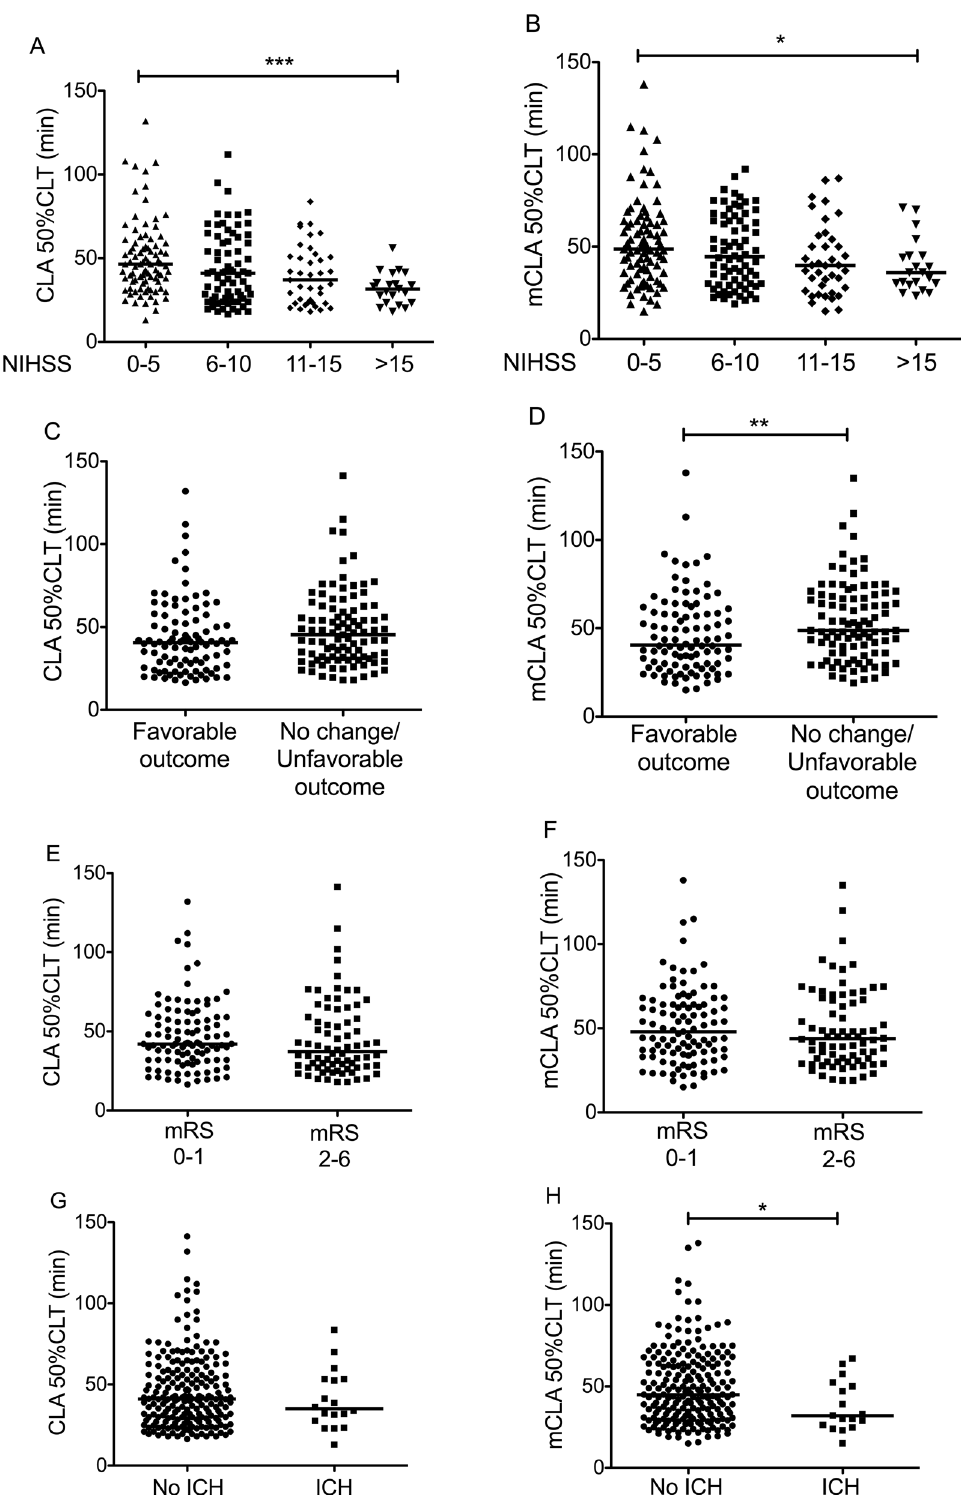
Figure 2. Association between 50% clot lysis time (50%CLT) parameter of the clot lysis assay (CLA) or modified clot lysis assay (mCLA) and the severity and outcomes of stroke. Association between the 50%CLT parameter of CLA and stroke severity ( A ), short term outcome of stroke ( C ), long-term outcome of stroke ( E ), and therapy-associated intracerebral hemorrhage ( G ). Association between the 50%CLT parameter of mCLA and stroke severity ( B ), short term outcome of stroke ( D ), long-term outcome of stroke ( F ), and therapy-associated intracerebral hemorrhage ( H ). CLA, clot lysis assay; mCLA, modified clot lysis assay including the effect of cfDNA and histones; 50% CLT, 50% clot lysis time, ICH, intracerebral hemorrhage; NIHSS, National Institutes of Health Stroke Scale, mRS, modified Rankin Scale. *p < 0.05, **p < 0.01, ***p < 0.001 [( A , B ) Kruskal–Wallis with Dunn-Bonferroni post hoc test, ( C – H ) Mann–Whitney U